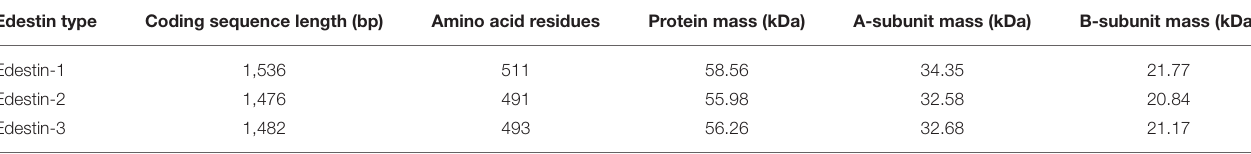
TABLE 4 | Sequence length, protein mass, and submit mass of three edestins.